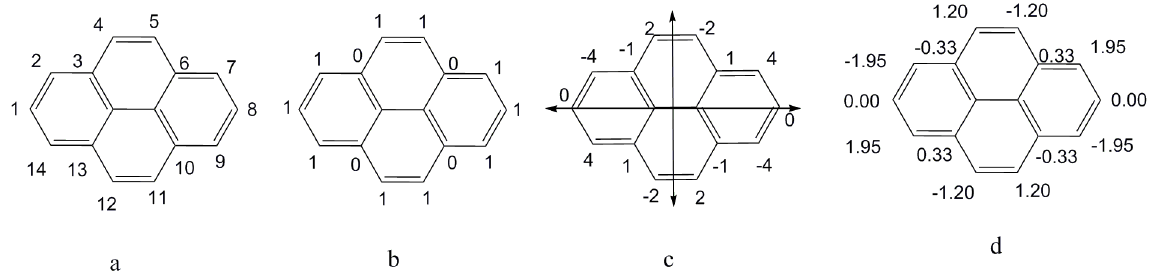
Figure 2. Atomic asymmetry of an achiral benzenoid. The reflection line of molecule was represented by double headed arrow. a) atom numbers; b) binary codes; c) atomic sums; d) weighted atomic sums.